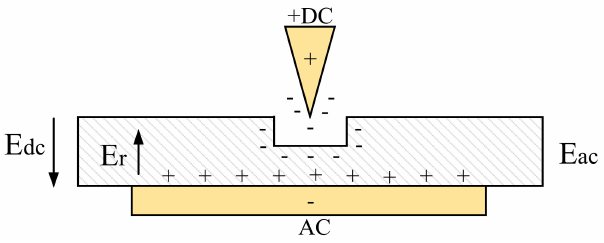
Figure 21. Diagram of the electric field of the needle-plane